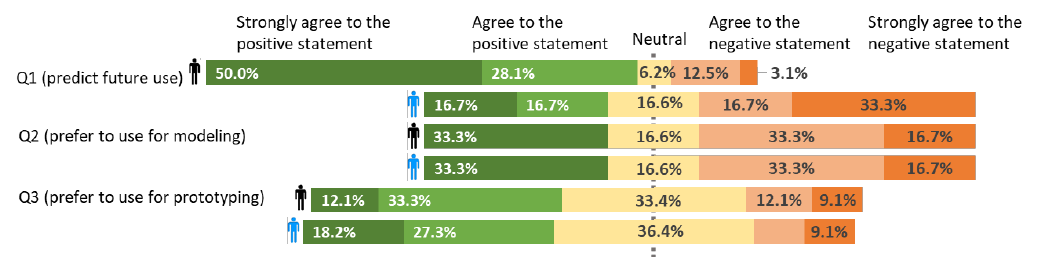
Fig. 17. Self-predicted future usage of